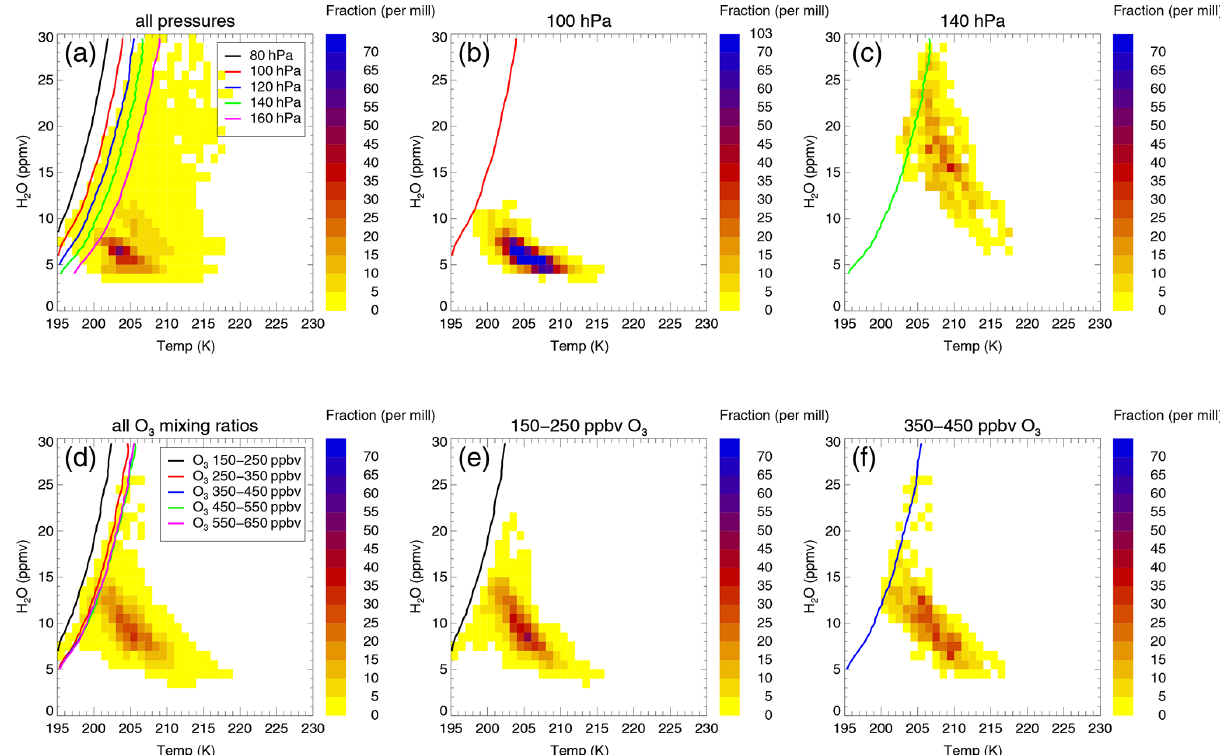
Figure 6. H 2 O–temperature relative frequency distributions and chlorine activation thresholds of different data groups (see Table 2) for the C2010 case and a latitude range of 30–35 ◦ N. The H 2 O–temperature relative frequency distribution is illustrated as a colour scheme. The colour marks the fraction of the considered data corresponding to an H 2 O and temperature bin (1ppmv H 2 O × 1K). The H 2 O- and temperature-dependent chlorine activation thresholds are marked as a line. Panels (a) – (c) are related to data groups with an ozone mixing ratio of 350–450ppbv: all data in the considered latitude and ozone range (30–35 ◦ N, 350–450ppbv O 3 ) (a) ; the data group defined by a latitude of 30–35 ◦ N, an ozone mixing ratio of 350–450ppbv O 3 and the 100hPa pressure level (b) ; and the data group defined by a pressure level of 140hPa and the same latitude and ozone range (c) . Panels (d) – (f) are related to data groups with a pressure level of 120hPa: all data in the considered latitude and pressure level (30–35 ◦ N, 120hPa) (d) ; the data group defined by a latitude of 30–35 ◦ N, a pressure level of 120hPa and an ozone mixing ratio of 150–250ppbv O 3 (e) ; and the data group defined by an ozone mixing ratio of 350–450ppbv and the same latitude and pressure level (f)